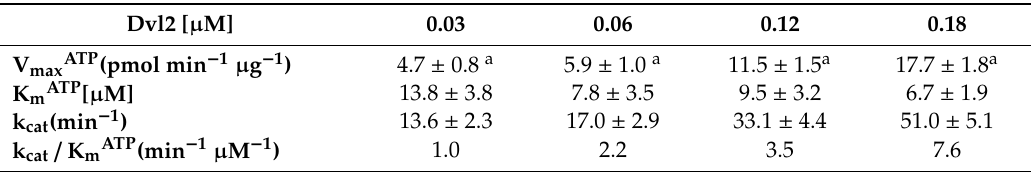
Figure 5. Kinetic analysis of CK1 ε acting on ATP and Dvl2. ( A ) Kinetic analysis of CK1 ε towards ATP increasing concentrations at fixed Dvl2 concentrations. ( B ) Kinetic analysis of CK1 ε towards Dvl2 increasing concentrations at fixed ATP concentrations. Reaction velocity rate (y axis) is represented as picomoles of incorporated phosphate on Dvl2 per minute per microgram of enzyme (pmol / min / µ g). Data are representative of three independent experiments. Bars indicate mean ± SD. Table 6. Representation of kinetic parameter values of CK1 ε obtained as a function of varying ATP concentrations at fixed DVL2 amounts.